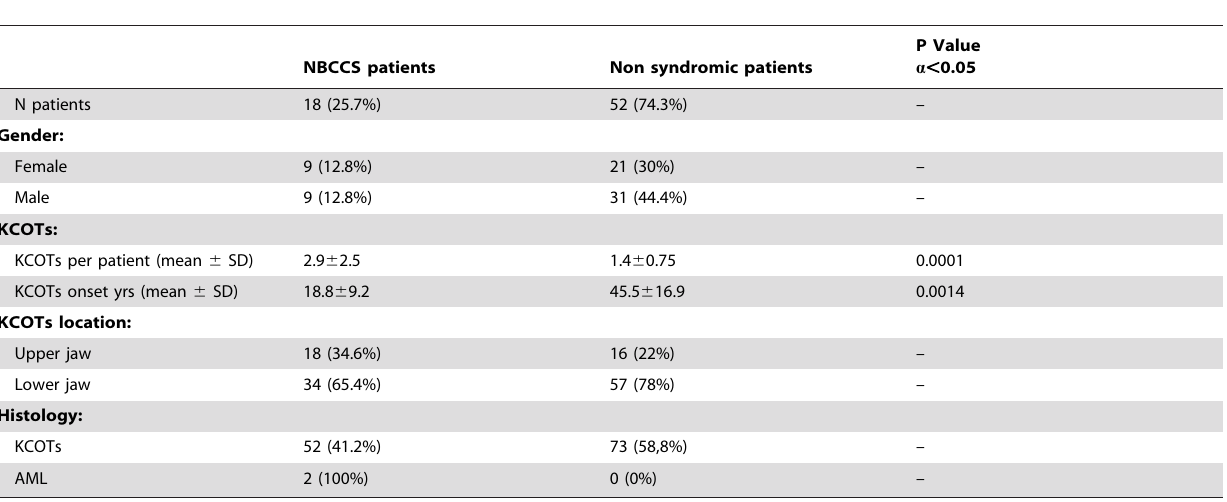
Table 1. Odontogenic tumors in patients with Nevoid Basal cell Carcinoma Syndrom and in patients with sporadic